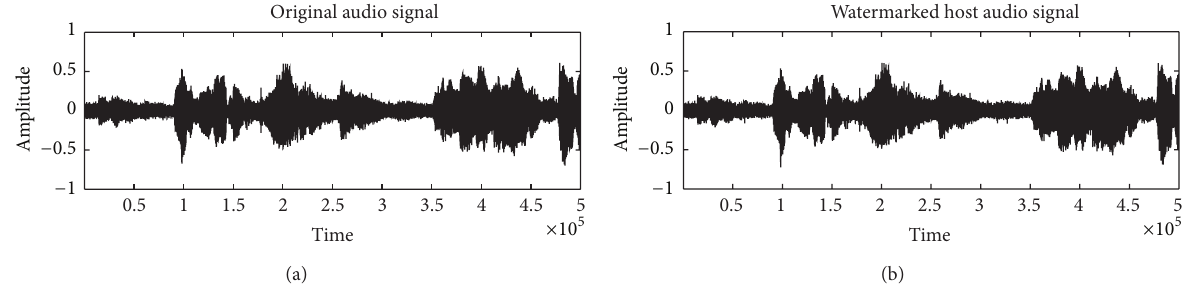
Figure 4: Original pop audio and the watermarked audio signal.